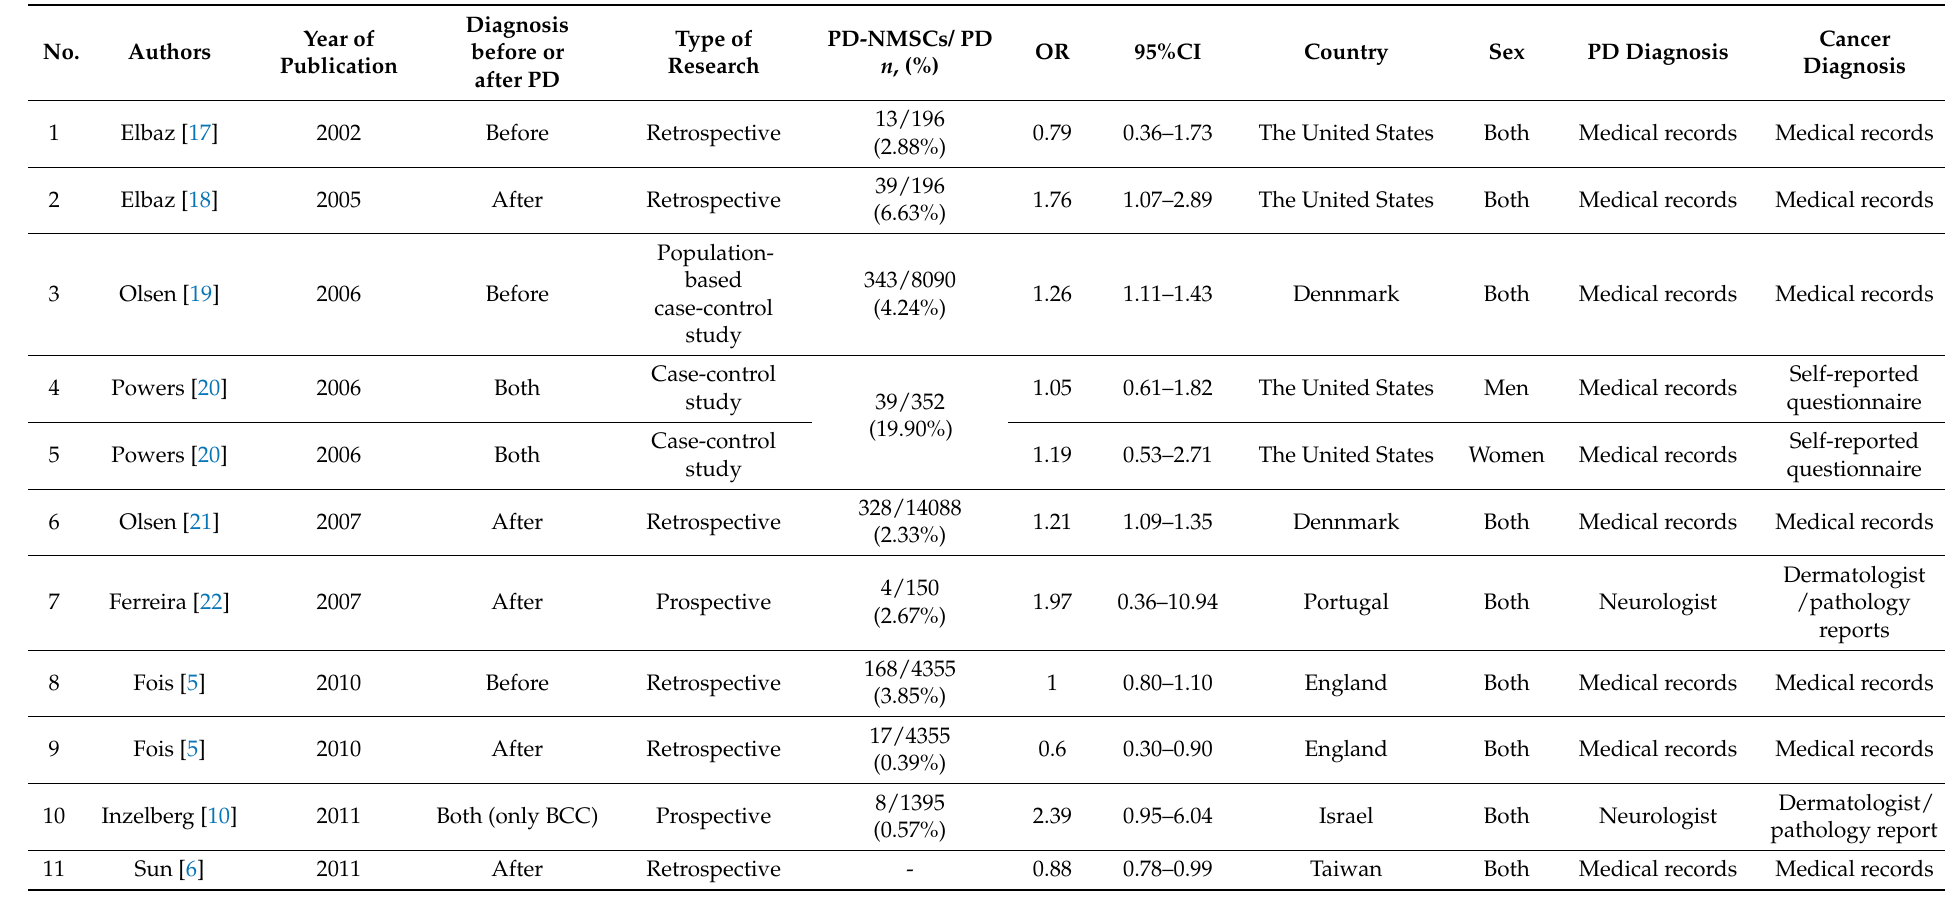
Table 1. Characteristics of the studies qualified for statistical analysis. PD—Parkinson disease, NMSCs—nonmelanoma skin cancers, BCC—basal cell carcinoma, OR—odds ratio, CI—confidence